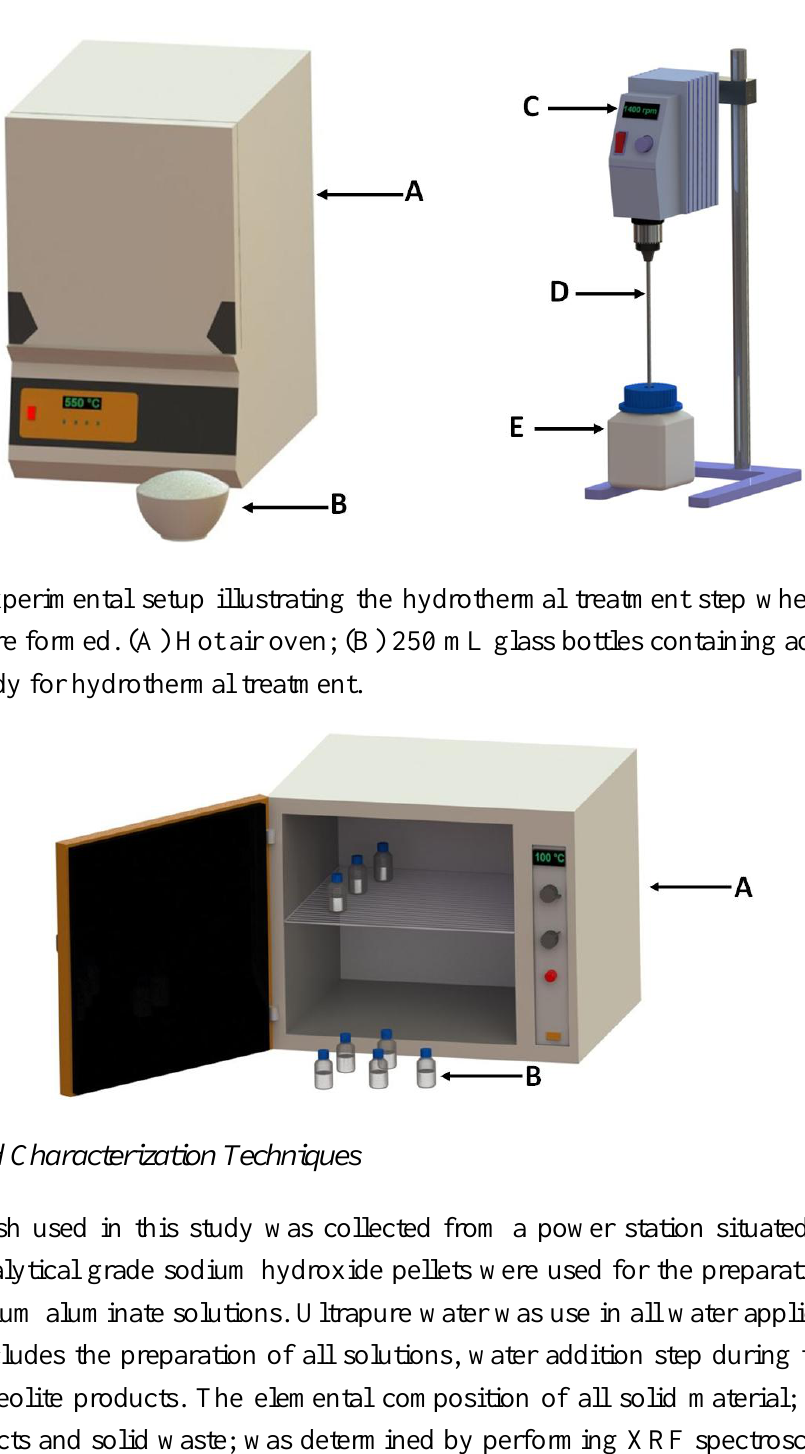
Figure 6. Experimental setup illustrating the fusion of ash and extraction of Si and Al from fused ash. (A) Electrical furnace; (B) Mixture of fly ash and NaOH powder in a crucible; (C) Overhead stirrer set at 1400 rpm; (D) 4-blade paddle impeller; (E) Rectangular mixing vessel.